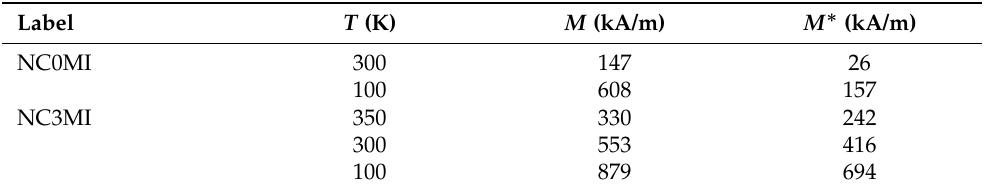
Table 1. The magnetization value determined from the solution of the Kittel equation ( M ) and from hysteresis loops ( M ∗ ) for NC0MI and NC3MI